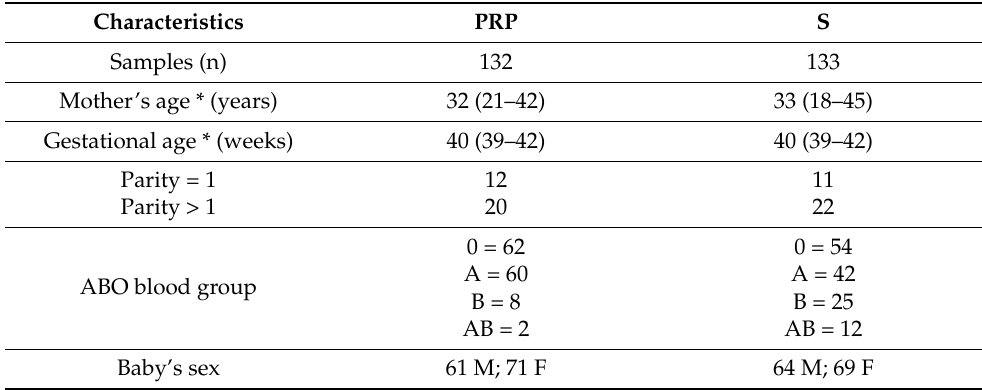
Table 1. Summary of the characteristics of mothers and babies, donors of the CB samples.